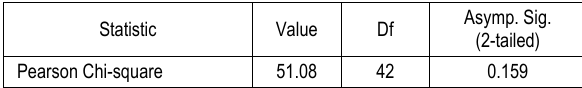
Table 5. Chi-square test for ethnic